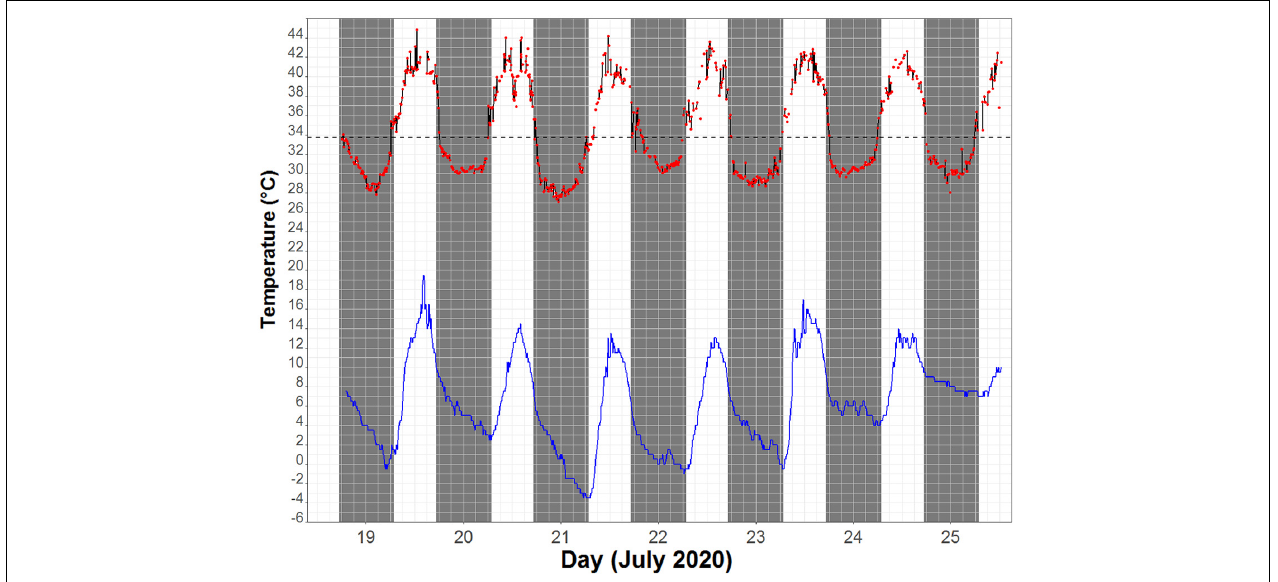
FIGURE 1 | An example of skin temperature (T s ) fluctuation of one individual (red line) and the corresponding ambient temperature (T a ) measured near the roosting site (blue line) over a 7-day period. Black dashed line depicts the torpor threshold (33.7 ◦ C), calculated as 5 ◦ C below the resting T s